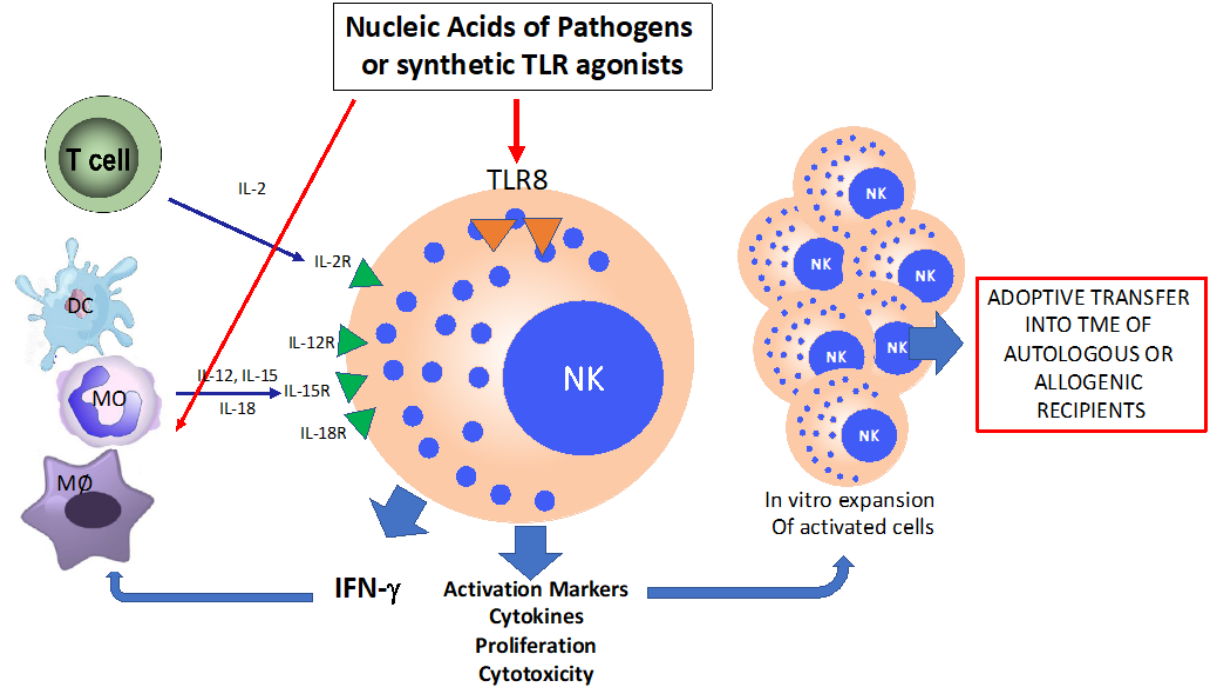
Figure 1. Schematic representation of direct NK cells activation through TLR8 engagement and indirect activation by accessory cells through cytokines.